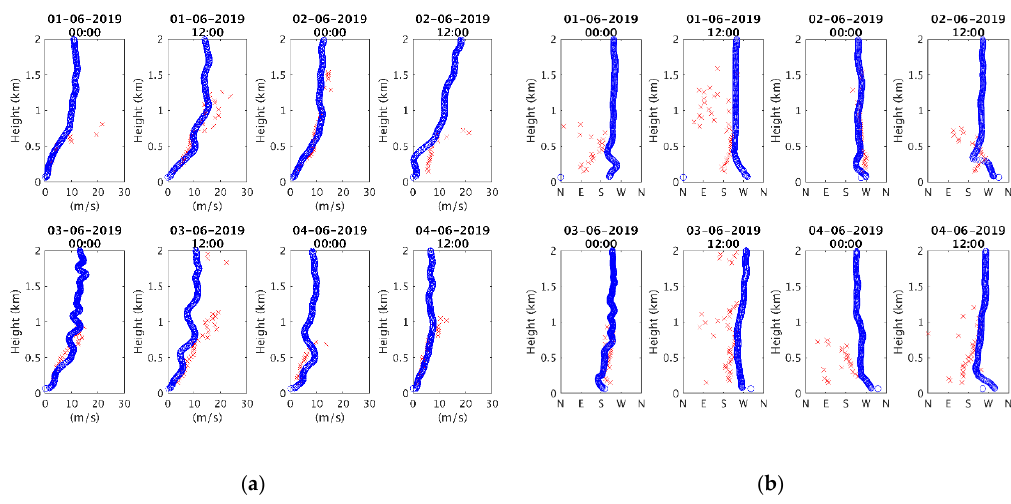
Figure 3. ( a ) Comparison of horizontal wind speed (m / s) according to KP LiDAR data (red cross) and upper air sounding data (blue circles) over a 4-day period (1 June, 2019, 00:00 UTC to 4 June, 2019, 12:00 UTC). ( b ) Comparison of horizontal wind direction according to LiDAR data (red cross) and upper air sounding data (blue circles) over a 4-day period (1 June, 2019, 00:00 UTC to 4 June, 2019, 12:00 UTC).